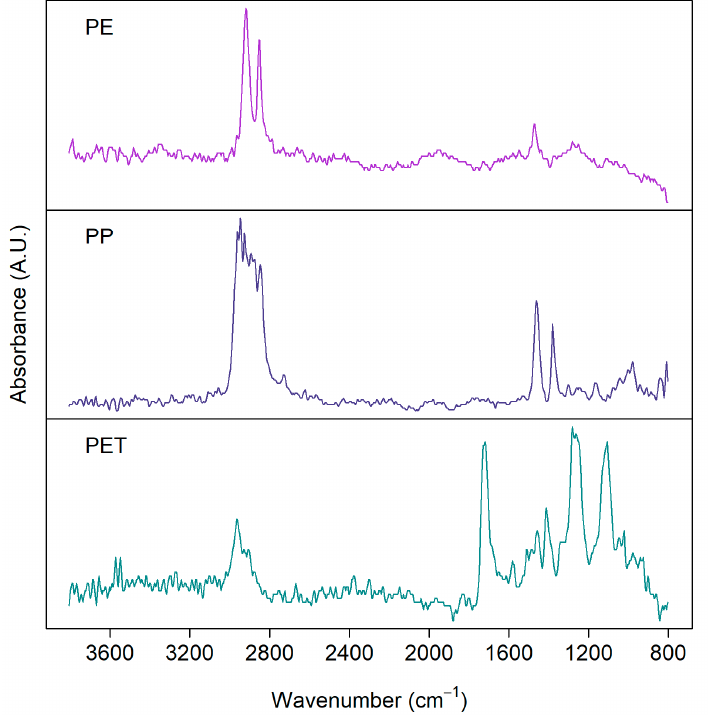
Figure 2. FTIR spectra of microplastics detected from environmental samples: polyethylene (PE), polypropylene (PP), polyethylene terephthalate (PET). Samples were measured with a focal plane array (FPA) detector in reflection mode from silver membrane filters.